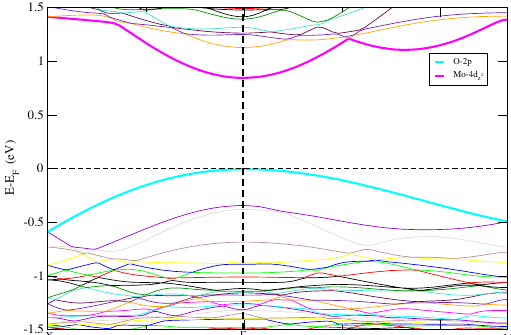
Figure 2. Electronic band structure of TiO 2 terminated HS along high symmetry points X(0.5,0,0)- Γ (0,0,0)-M(0.5,0.5,0.0) and the horizontal dashed line implies the E